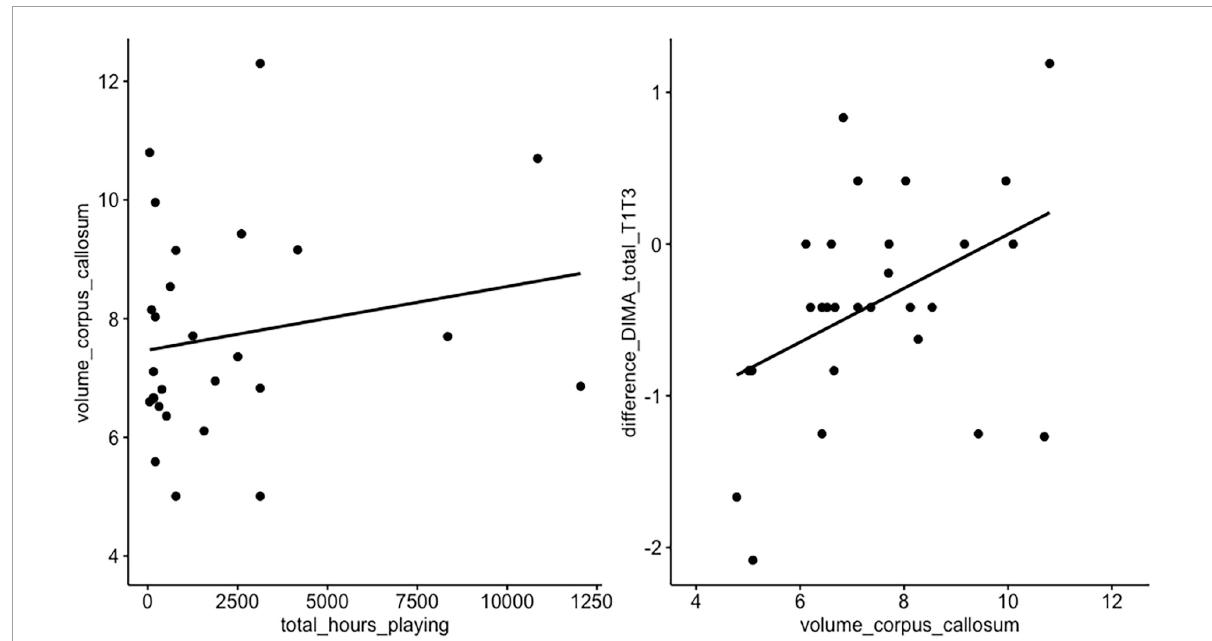
FIGURE3 Correlation hours of playing vs. volume of corpus callosum vs. language. A linear correlation was visually observed, but not statistically confirmed, between volume of corpus callosum and postoperative language course (T1 vs. T3, t = 0.79, df = 22, p -value = 0.43) and between the total hours of playing and corpus callosum volume ( t = 1.57, df = 18, p -value =